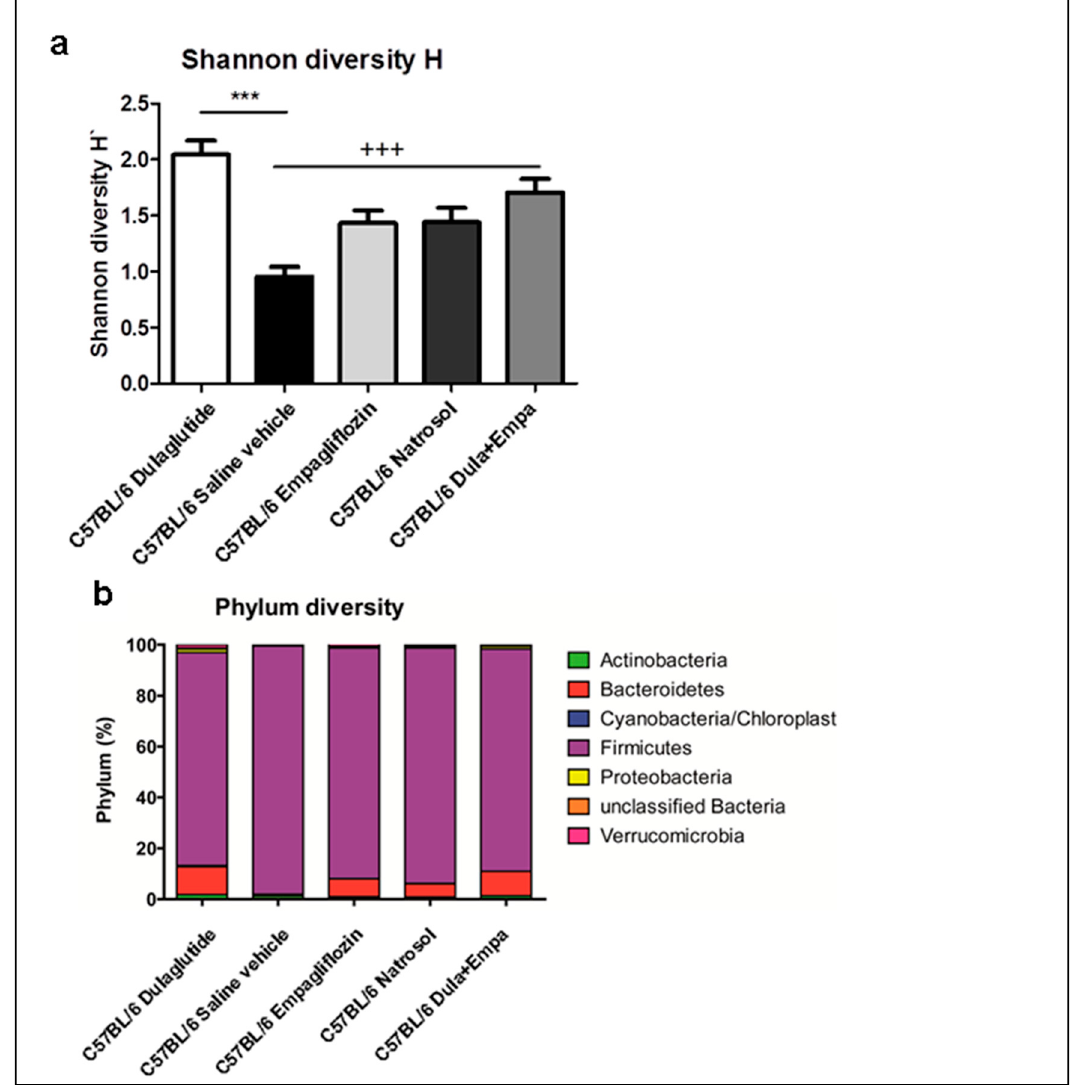
Figure 5. Microbiome diversity ( a ) Analysis of the genus diversity of intestinal microbiota using the Shannon H score. Data are presented as mean ± SEM. Unpaired t -test with Welsh-correction was used for comparison between treatment and control group. ( b ) Detailed composition of the phylum diversity. C57BL/6 Dulaglutide: n = 10, C57BL/6 Saline vehicle: n = 10, C57BL/6 Empagliflozin: n = 10, C57BL/6 Natrosol: n = 10; C57BL/6 Dula + Empa: n = 9 . * p < 0.05; ** p < 0.01; *** p < 0.001 was used for comparison of Dulaglutide vs. Saline vehicle. + p < 0.05; ++ p < 0.01; +++ p < 0.001 was used for comparison of Dula + Empa vs. Saline vehicle .